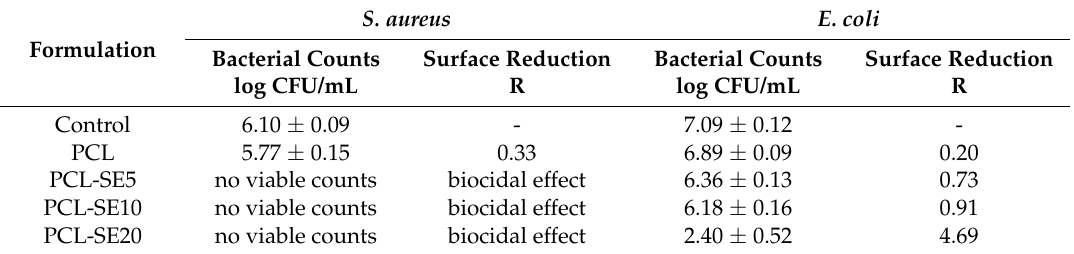
CFU—Colony Forming Units; R—Surface